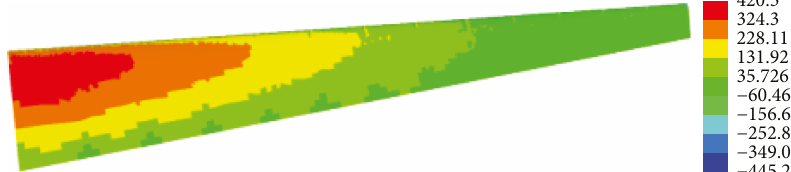
Figure 34: Stress cloud diagram of the lower wing with the layer angle being 90 and 0.